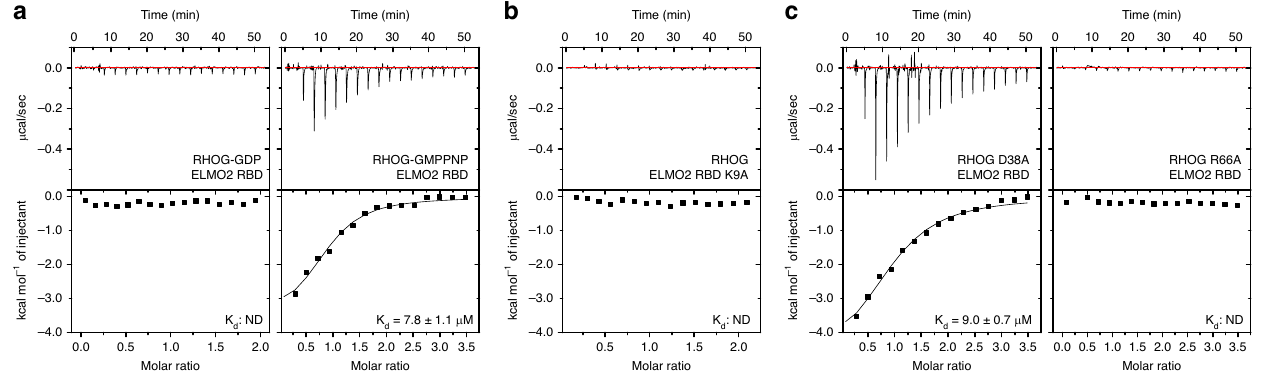
0.0 Fig. 5 Mutations of the RHOG – ELMO2 RBD interface disrupts interactions. ITC binding assay for ( a ) Wild-type RHOG in the inactive GDP-bound state (left) or active GTP-bound state (right) with wild-type ELMO2 RBD ; ( b ) K9A mutant of ELMO2 RBD with wild-type RHOG; and ( c ) D38A and R66A mutants of activated RHOG with wild-type ELMO2 RBD . For ITC assays showing no binding, the K d was not determined (ND). The positions of these residues are shown in Fig. 4c. The experiments were performed independently three times with similar